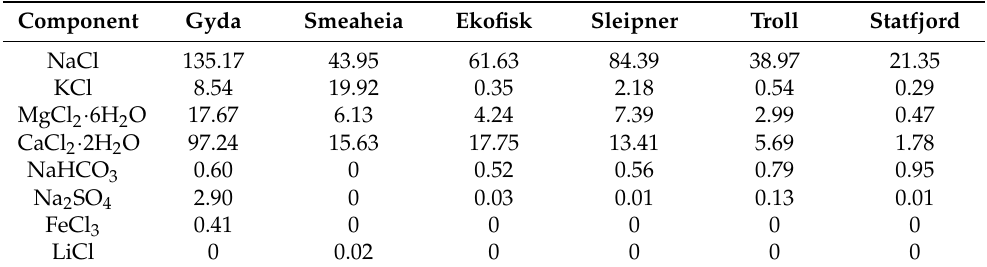
Table 1. Compositions of the different formation waters [24,30]. The compounds (in grams) were mixed with deionized water to make up a total of 1 L